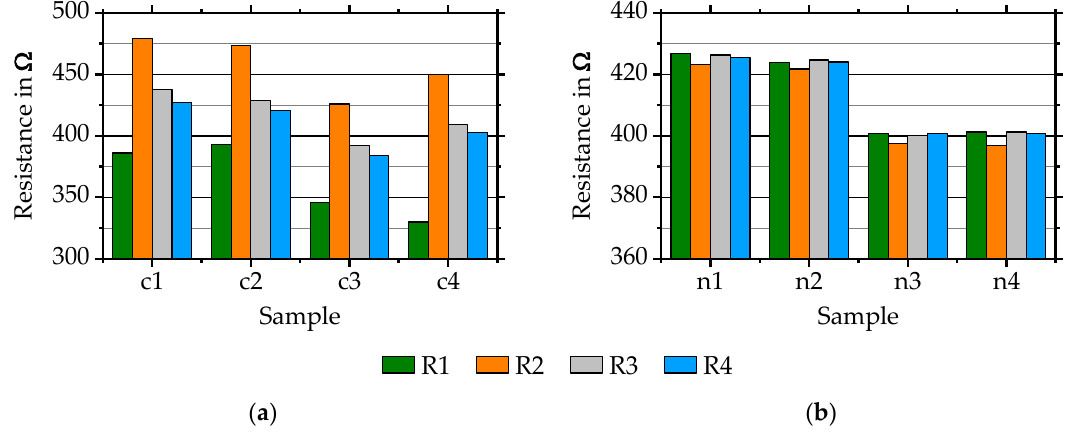
Figure 3. Initial resistances R1–R4 of ( a ) four Constantan samples c1–c4 and ( b ) four NiCr 80 / 20 samples n1–n4 deposited after each other.